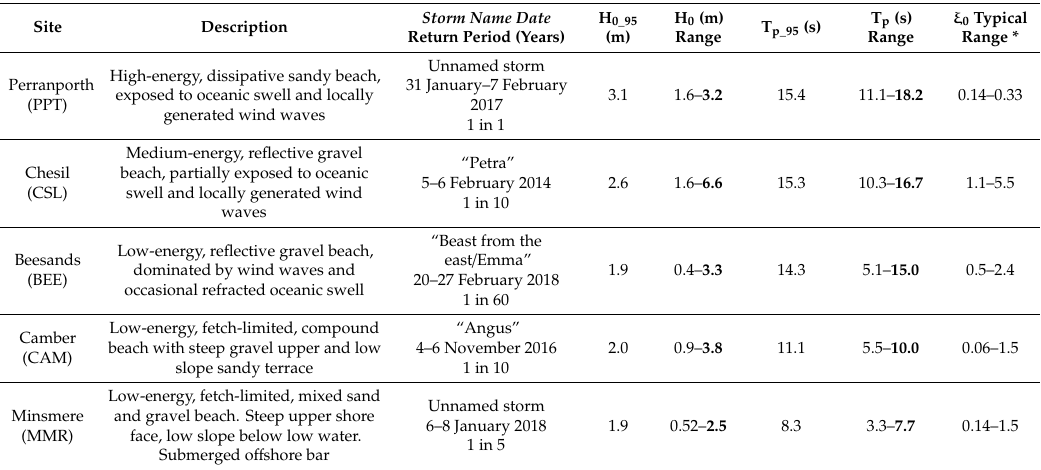
Table 2. Site descriptors, storm name, and return period in years; 95% exceedance threshold o ff shore wave height (H _95 ) and period (T p _95 ), and the range of H 0 and T p in the new dataset were collected, with maximum values quoted in